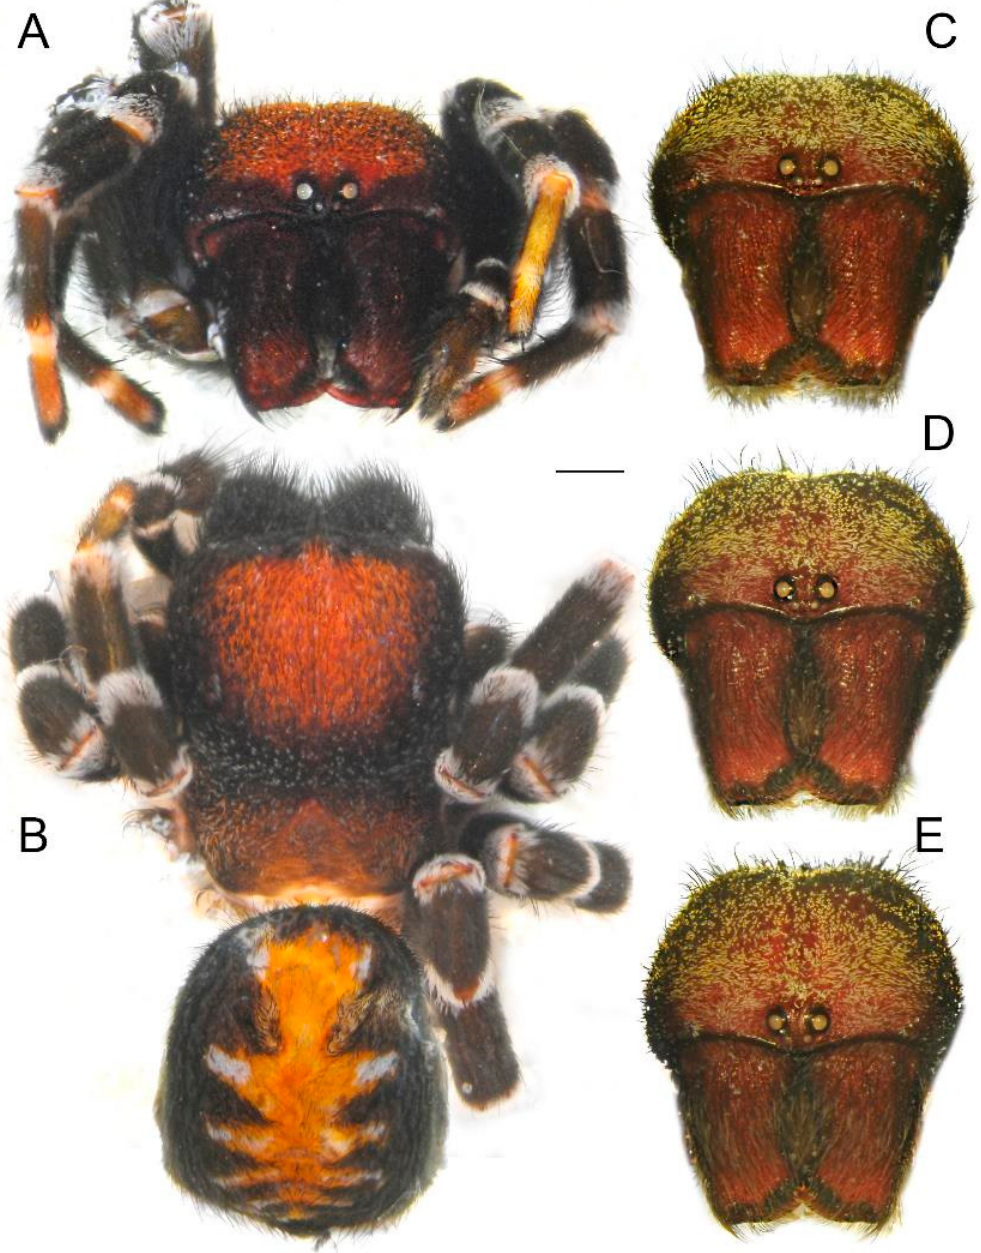
Figure 11. Frontal views and habitus of males of Loureedia jerbae and Loureedia maroccana (holotype). ( A ) L. jerbae , prosoma, frontal view; ( B ) L. jerbae , habitus, dorsal view; ( C ) L. maroccana , frontal view; ( D , E ) L. maroccana , slightly pushed down, showing changes in the perception of the carapace. Scale bar: 1.0 mm. Diagnosis. The male palp of L. jerbae (Figures 4B, 6B, 7B and 8B) is most similar to that of L. phoenixi (Figures 4A, 6A, 7A and 8A) , as the arms of the conductor are almost the same length and bear pointed tips and the terminal portion of the prolateral arm curves retrolaterally (Figure 4A,B). The male palp of L. jerbae differs from that of L. phoe- nixi, as the longer stem of the conductor bears only a slight curvature along its ectal margin